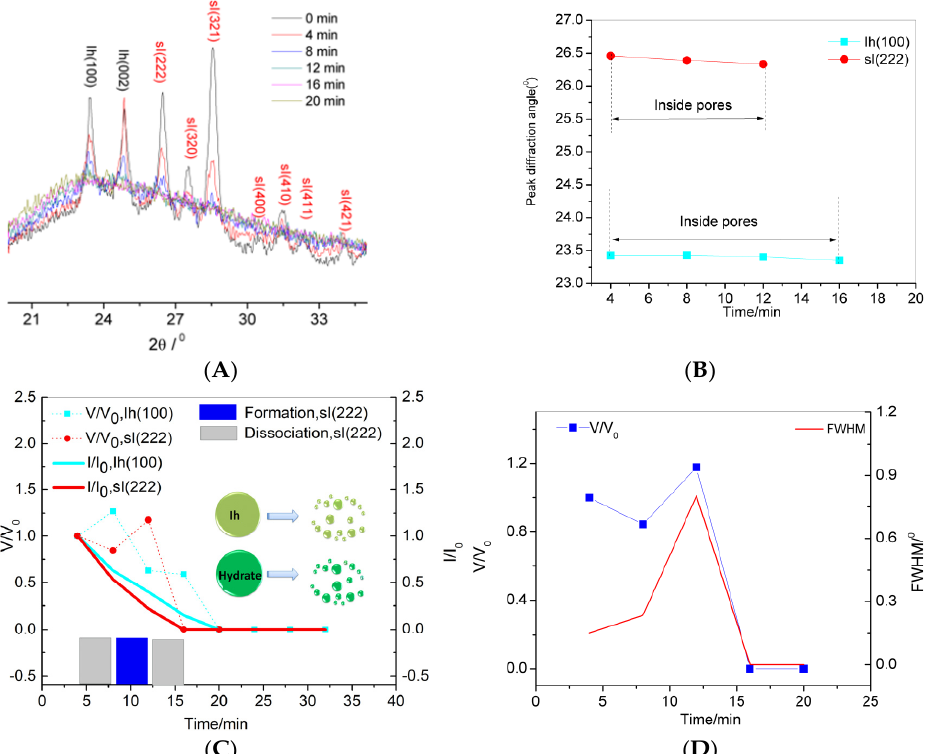
Figure 3. Dissociation process at 268 K. ( A ) XRD patterns. ( B ) The peak diffraction angle change of sI(222) and Ih(100), with respect to the time calculated from the XRD patterns. The peak diffraction angle is not shown when the peak intensity was 0. ( C ) The volume change of the hydrate or ice Ih, V/V 0 , and peak intensity change of sI(222) or Ih(100) inside the pores, I/I 0 . ( D ) The volume change of the hydrate, V/V 0 , and full width at half maximum (FWHM) change of sI(222). Figure 3C shows the relative volume change of the hydrate or ice Ih (V/V 0 ) and rel- ative peak intensity change of sI(222) or Ih(100) inside the pores (I/I0). The relative vol- ume change of the hydrate or ice Ih is the ratio of the peak area of sI(222) or Ih(100) inside the pores to the peak area of sI(222) or Ih(100) inside the pores at the initial time (4 min). The relative peak intensity change of sI(222) or Ih(100) is the ratio of the peak intensity of sI(222) or Ih(100) inside the pores to the peak intensity of sI(222) or Ih(100) inside the pores at the initial time (4 min). Figure 3C shows that the dissociation process of the hy- drates and ice Ih contained multiple reformation processes. The slope of the volume content of the hydrate can represent the dissociation or reformation rate. Figure 3C also shows that the reformation/dissociation rate of the hydrate was controlled by the volume of ice. When the volume of ice was larger, the reformation/dissociation rate of the hydrate was slower. The full width at half maximum (FWHM) change of sI(222) is shown in Figure 3D. During the dissociation process, the FWHM continued to increase, meaning that the hydrate particles became smaller. At 12 min, the FWHM was maximized, and the hydrate decomposed very rapidly. The reformation/dissociation rate of the hydrates was also controlled by the size of the hydrate particles. The large volume of ice and large hy- drate particle size mean that the solid phase volume in the nanopore is large, and the relative liquid volume is small. A large liquid volume means that the average pore di- ameter of the nanopores is large. Different average pore sizes represent different hydrate phase equilibrium curves. Thus, the dissociation processes have different driving forces. Therefore, the volume of ice and the size of the hydrate particles are important variables